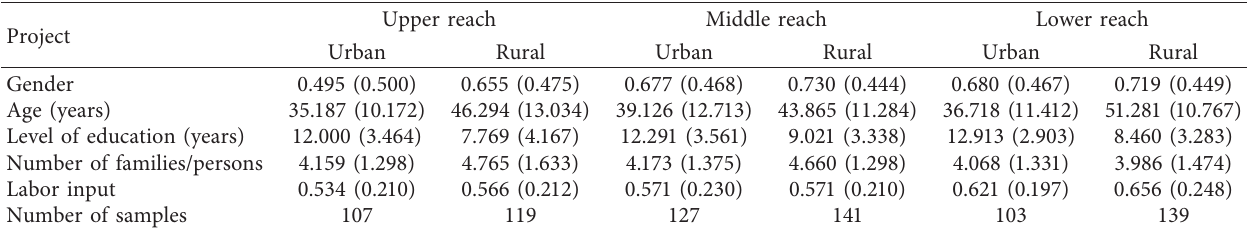
Table 2: Descriptive statistics of the sample.